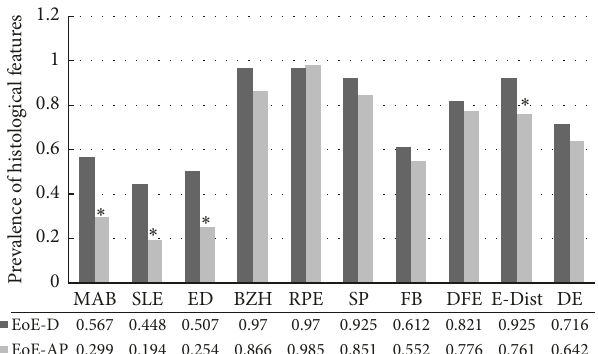
Figure 1: Comparison of the degree/stage of eosinophil-rich inflam- mation on the biopsies of EoE-D and EoE-AP patients . MAB: microabscess, SLE: superficial layering, ED: epithelial desquama- tion, BZH: basal zone hyperplasia, RPE: rete pegs elongation, SP: spongiosis or increased intracellular space, FB: lamina propria fibro- sis, DFE: diffuse or focal distribution, E-Dist: distribution around rete pegs, and DE: degranulation. Fibrosis (FB) was evaluable in 57 (EoE-D) and 54 (EoE-AP) patients and was positive in 41 (71.9%) and 37 (68.5%), respectively, 𝑝 value 0.85 (Chi-square test on 1 df = 0.03, 𝑝 = 0.85). ∗ Statistically